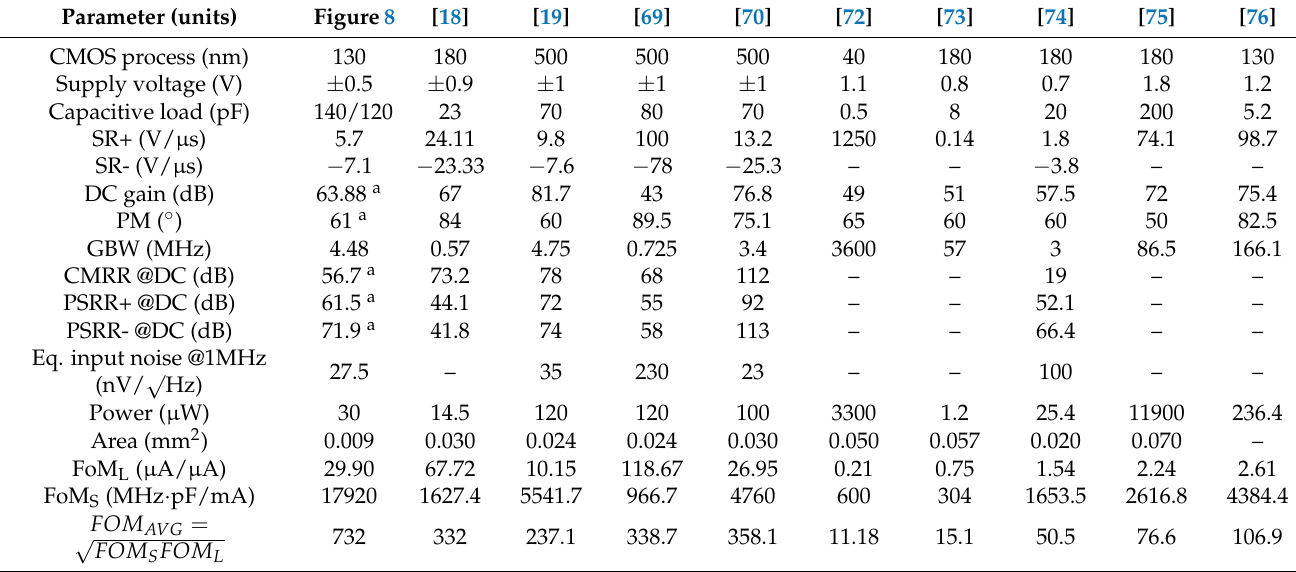
Table 1. Summary of measurement results and performance comparison.